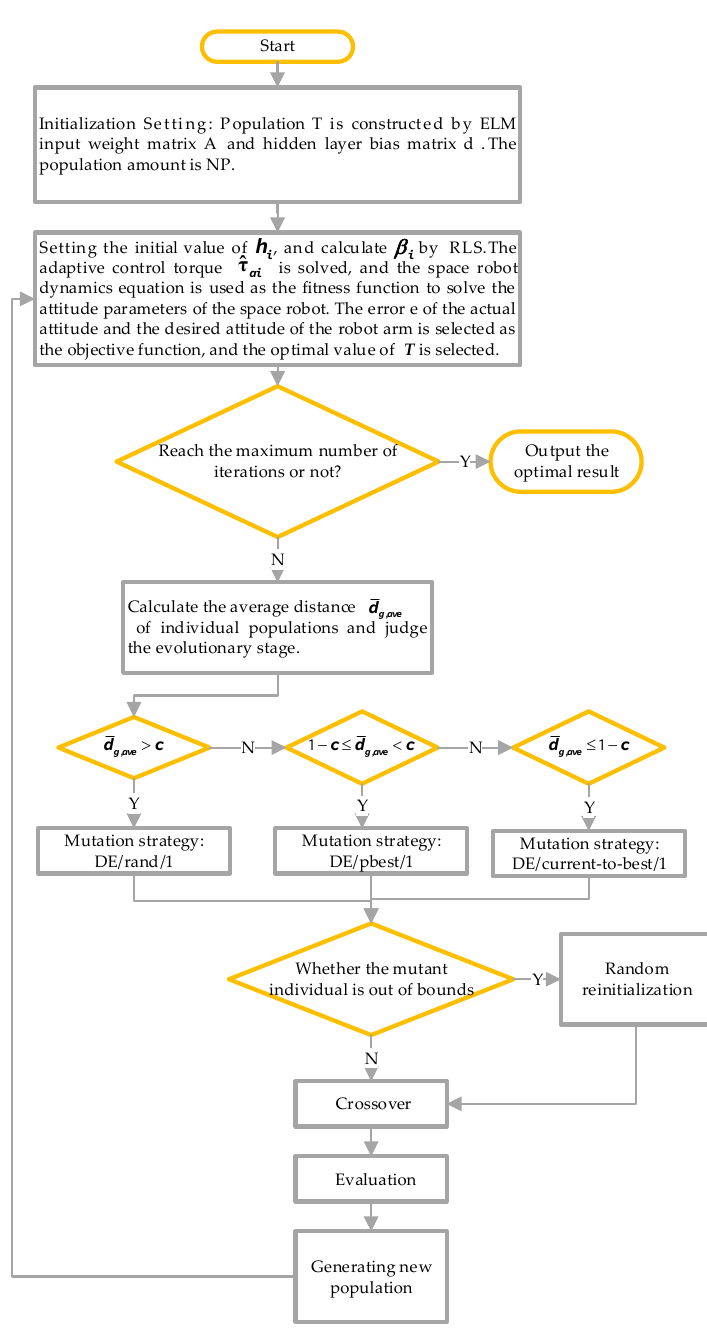
Figure 4. The improved Strategy Self-Adaptation Differential Evolution (SSADE) algorithm flow chart.